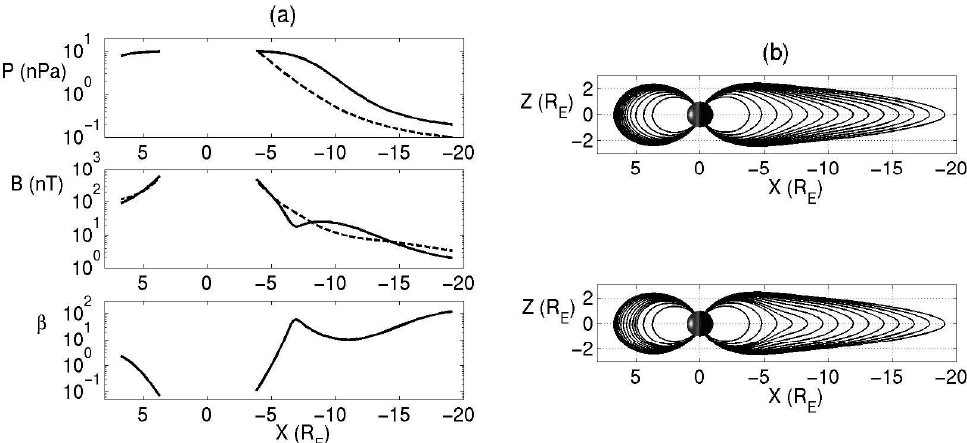
Fig. 5. (a) Sun-Earth axis profiles of P , | B | and β for the disturbed-time computation; the dashed line in the top plot represents the SK pressure used in the previous case, while the dashed lines in the middle plot show | B | from the T96 model; (b) Noon-midnight plane cross sections of constant flux surfaces for the Tsyganenko field (top) and the computed 3-D disturbed-time equilibrium field (bottom).